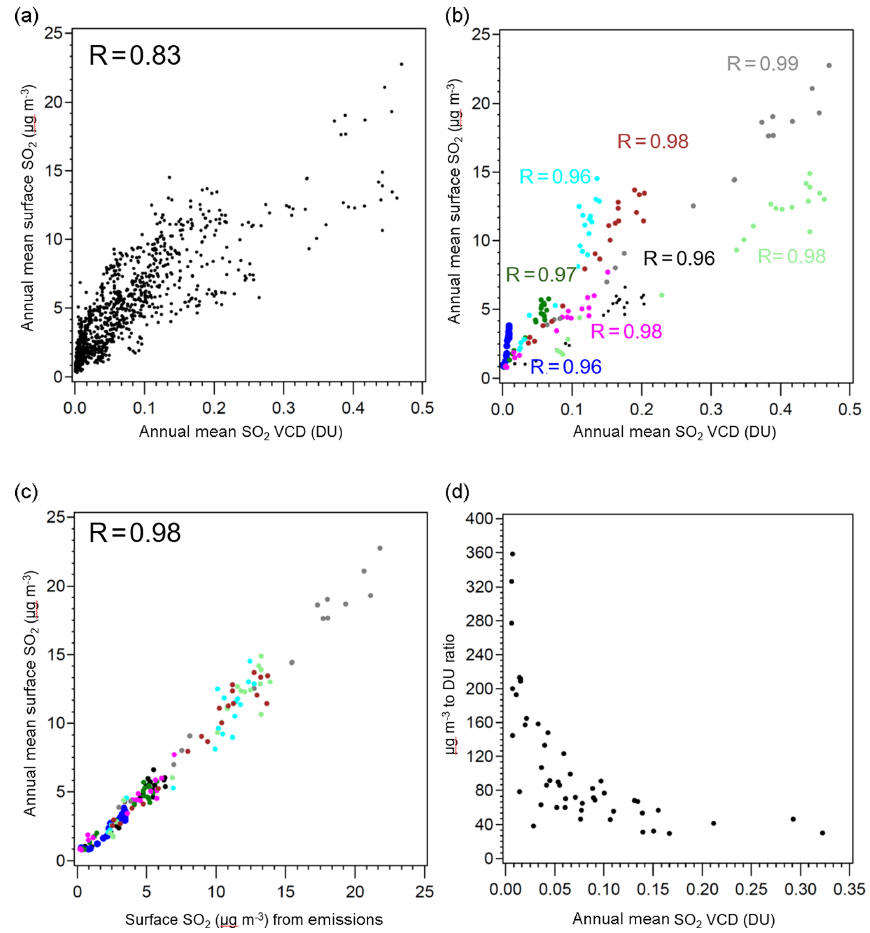
Figure 9. (a) A scatter plot of annual mean surface SO 2 from CASTNet and CAPMoN vs. VCDs calculated from EPA and NPRI point-source emission inventories. The correlation coefficient between the two data sets is 0.83. (b) A subset of the scatter plot from panel (a) for eight sites (shown by different colours). The correlation coefficients for individual sites are between 0.96 and 0.99. (c) The same plot as (b) , but for mean SO 2 VCDs multiplied by a site-specific surface-concentration-to-column ratio. The correlation coefficient is 0.98. (d) The site-specific surface-concentration-to-column ratio as a function of the 1980–2015 mean SO 2 VCD. Each dot represents one site. Only the 50 regional surface SO 2 sites with 15 or more years of data between 1980 and 2015 were used in this